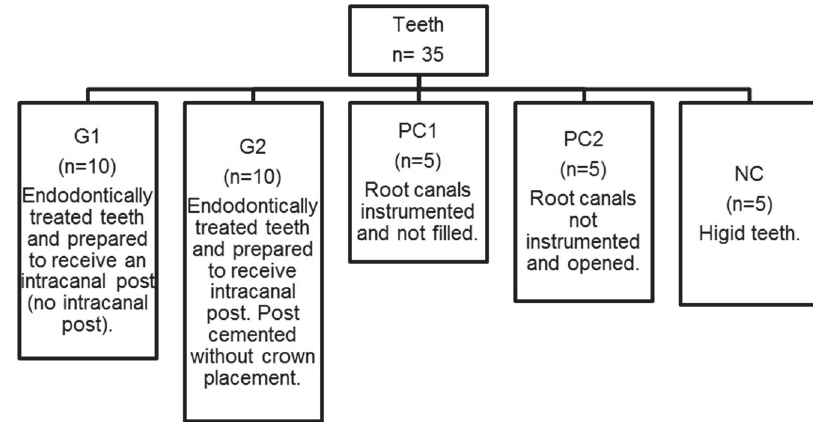
Figure 1- Flowchart of the experimental